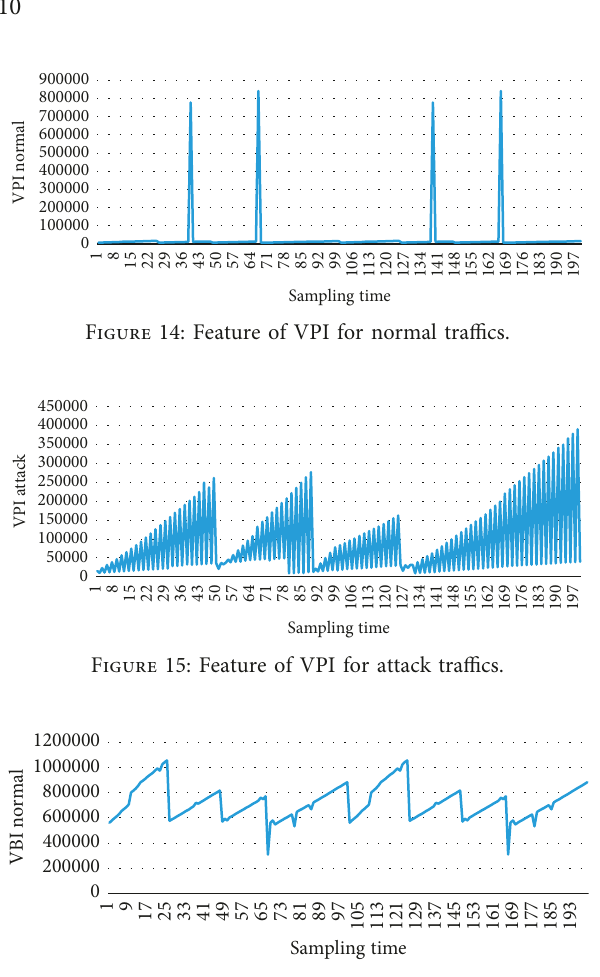
Figure 16: Feature of VBI for normal traffics.